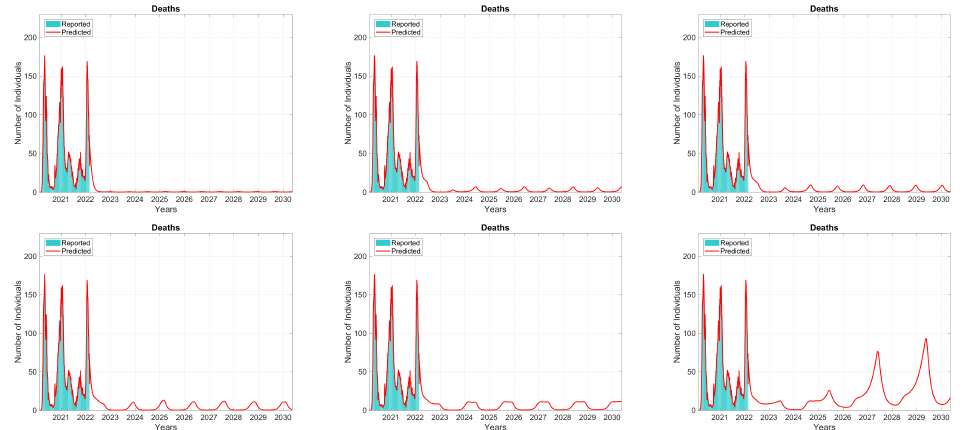
Figure 7. Predictions of daily deaths in Canada considering periodic vaccination booster campaigns with periods of 270, 360, 390, 450, 540, and 720